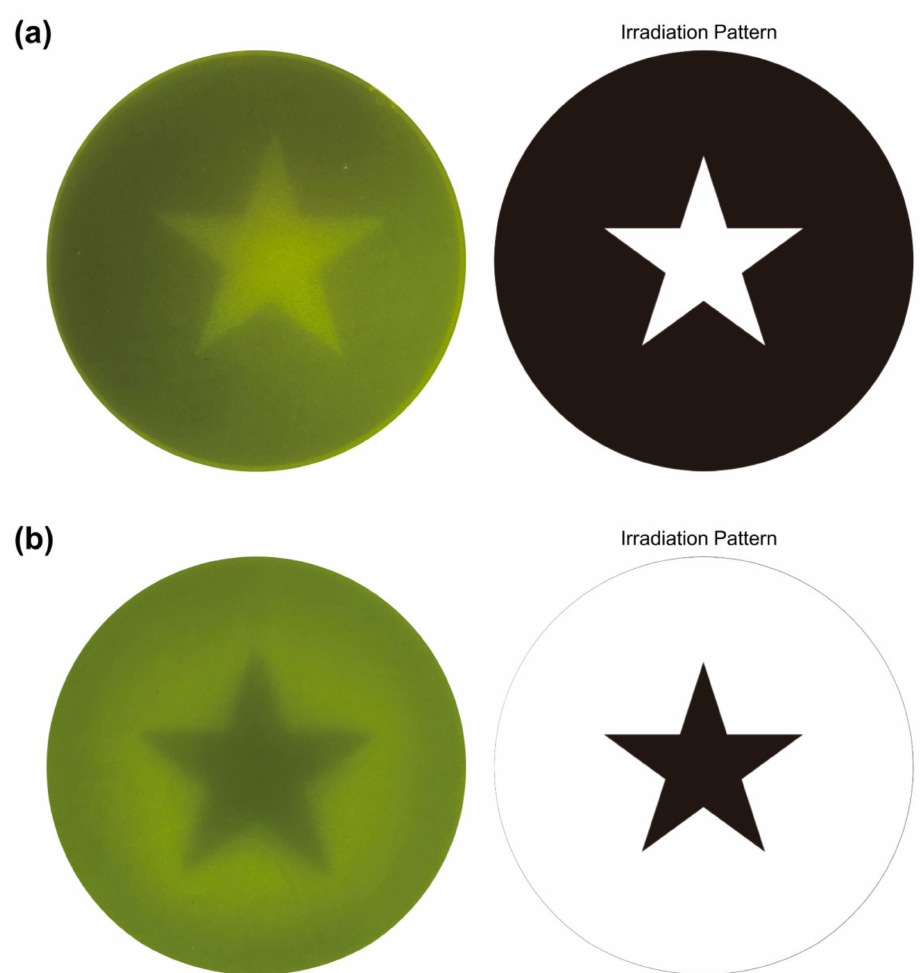
Figure 5. Light switchable spatial activation. Cells transformed with the 1 × CYC plasmid were plated on MD agar plates and illuminated with blue light for 10 h through a photomask with a star-shaped shield. The fluorescent pattern on the agar plate could precisely reproduce the pattern on the photomask, showing that the optogenetic system has a good degree of spatial control. The masks used for ( a , b ) are completely